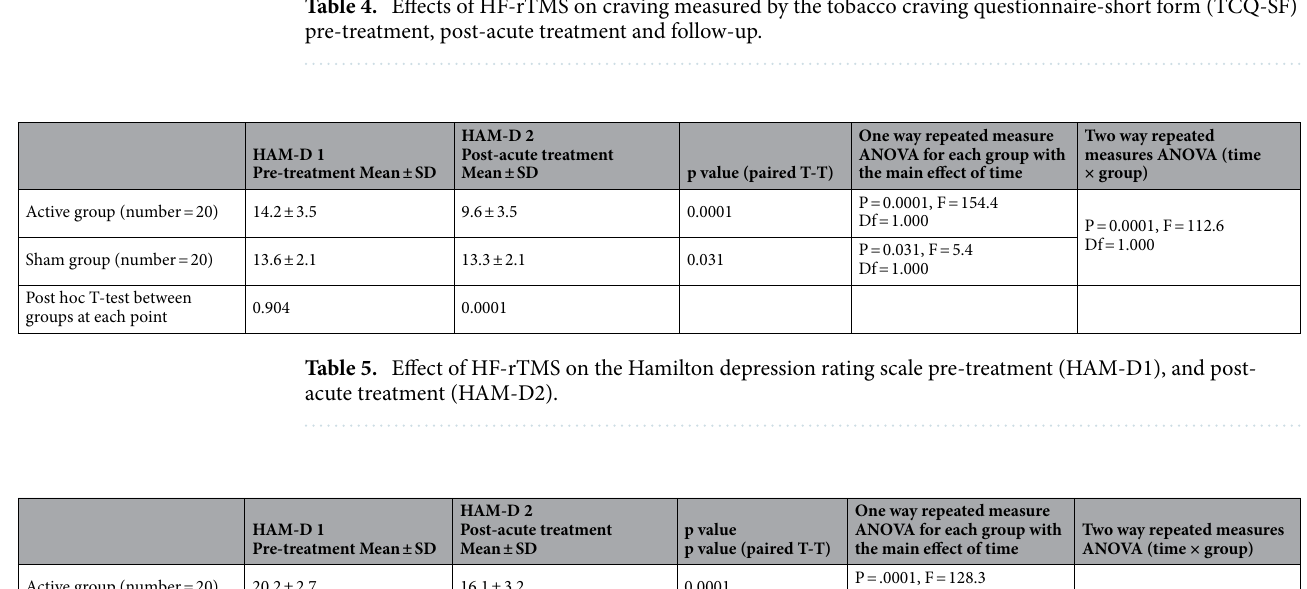
HAM-D 1 Pre-treatment Mean ±